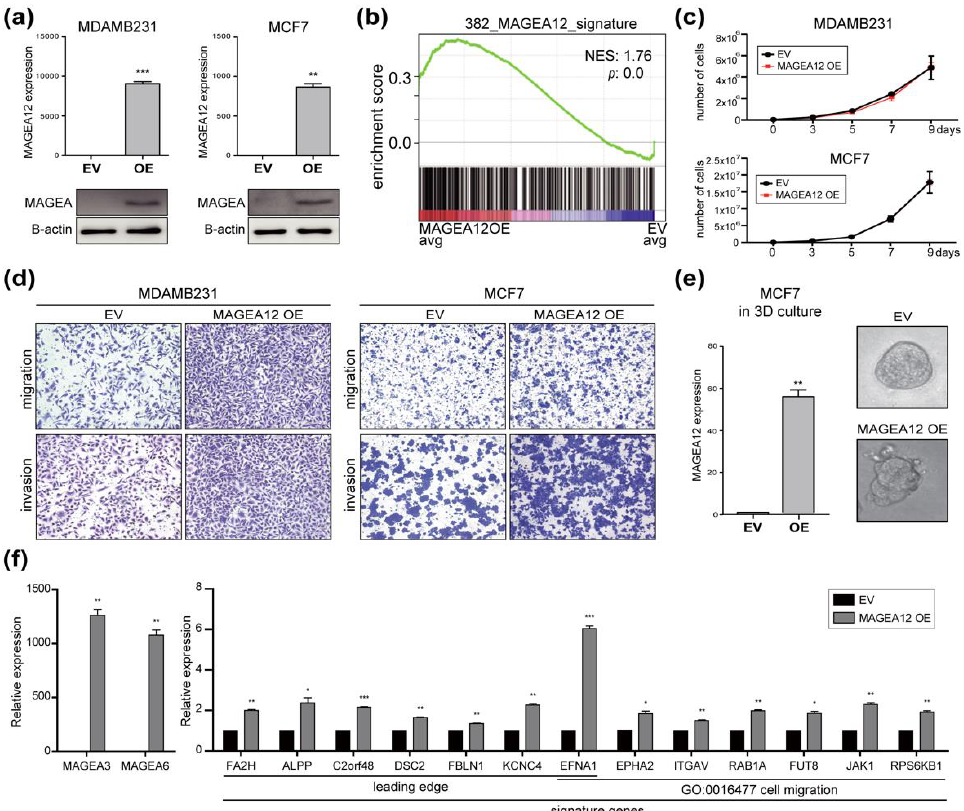
Figure 5. MAGEA12 overexpression promotes aggressive behavior in breast cancer cells. ( a ) MAGEA12 levels in MAGEA12-overexpressing MDAMB231 and MCF7 cells, as determined by qRT-PCR ( top ) and Western blotting ( bottom ). (** p -value < 0.001, *** p -value < 0.0001). ( b ) GSEA of the 382 signature genes in breast cancer cell lines relative to their MAGEA12 expression. ( c ) Proliferation of the MAGEA12-overexpressing cell lines between 0 and 9 days. ( d ) Migration and invasion assays with the MAGEA12-overexpressing cell lines. ( e ) 3D culture of MCF7 cells that overexpressed MAGEA12 or empty vector (control). (** p -value < 0.001). ( f ) Expression of MAGEA3, MAGEA6, selected target genes in MAGEA12-overexpressing cell. (* p -value < 0.01, ** p -value < 0.001, *** p -value < 0.0001).